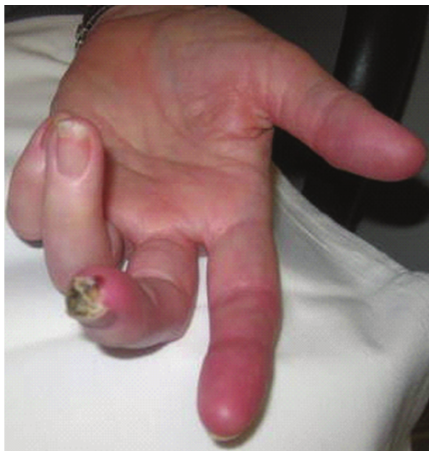
Figure 1: True digital ulcer.